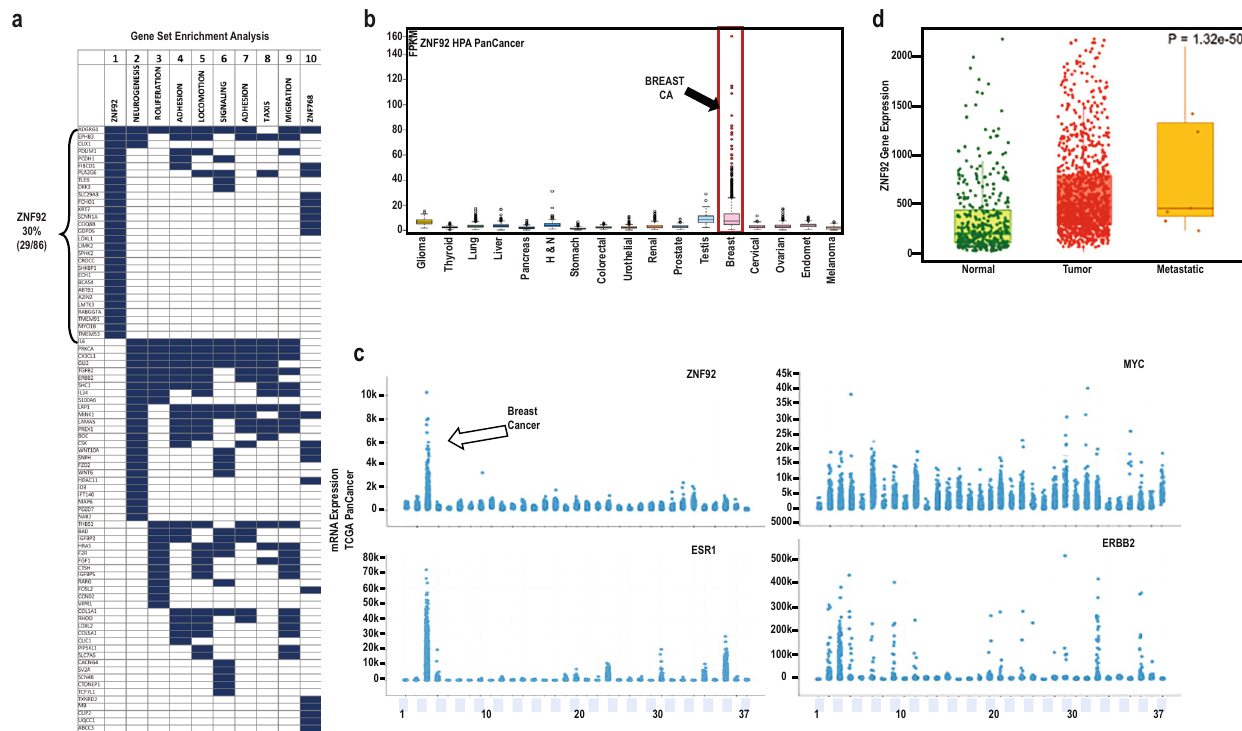
Fig. 2 ZNF92 expression in human tumors. a Gene Set Enrichment Analysis (GSEA) of HDAC1/7-SE upregulated genes. The top 10 pathways are depicted in the GSEA heatmap: the blue boxes mark 86 HDAC1/7-SE upregulated genes (rows) in each column that represents a different gene set in rank order (ZNF92 fi rst column). The p -value range for the top ten gene sets is 1.47e − 11 to 6.5e − 16 (see Supplementary Table 3 for details). The analysis is carried out using the GSEA online tool. b Human Protein Atlas (HPA) PanCancer expression analysis of ZNF92 RNA- seq data from 17 cancer types visualized with box plots, shown as median and 25th and 75th percentiles. Points are displayed as outliers if they are above or below 1.5 times the interquartile range. See Supplementary Table 4 for the complete list of tumor types. c The relative mRNA expression of ZNF92, Estrogen receptor (ERSR1), HER2 (ERBB2) and MYC in the cBioPortal TCGA PanCancer dataset that includes 37 tumor types with 10,967 samples. See Supplementary Table 5 for the complete list of 37 tumor types. Breast cancer is the third tumor type from the left. d The relative ZNF92 mRNA expression in tumor, normal and metastatic tissues in the TNMplot database that has RNA-seq data of TCGA including 730 normal, 9886 tumor and 394 metastatic samples 49